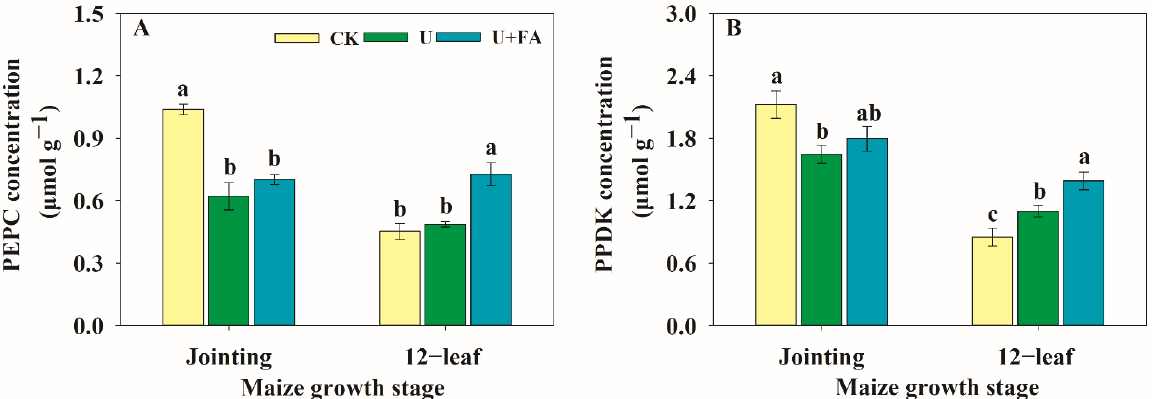
Figure 4. Effects of different fertilization treatments on the concentrations of photosynthetic key enzymes of phosphoenolpyruvate carboxylase (PEPC, ( A )) and pyruvate phosphate dikinase (PPDK, ( B) ) in maize leave at the jointing and V12 stages, in 2018. The treatments include: no nitrogen fertilizer (CK); application of urea (U); combined application of urea and fulvic acid solution (U+FA). The values are means of four replicates, and the error bars are standard errors. Different letters indicate significant differences between treatments for a same growth stage according to SNK’s test at p < 0.05.